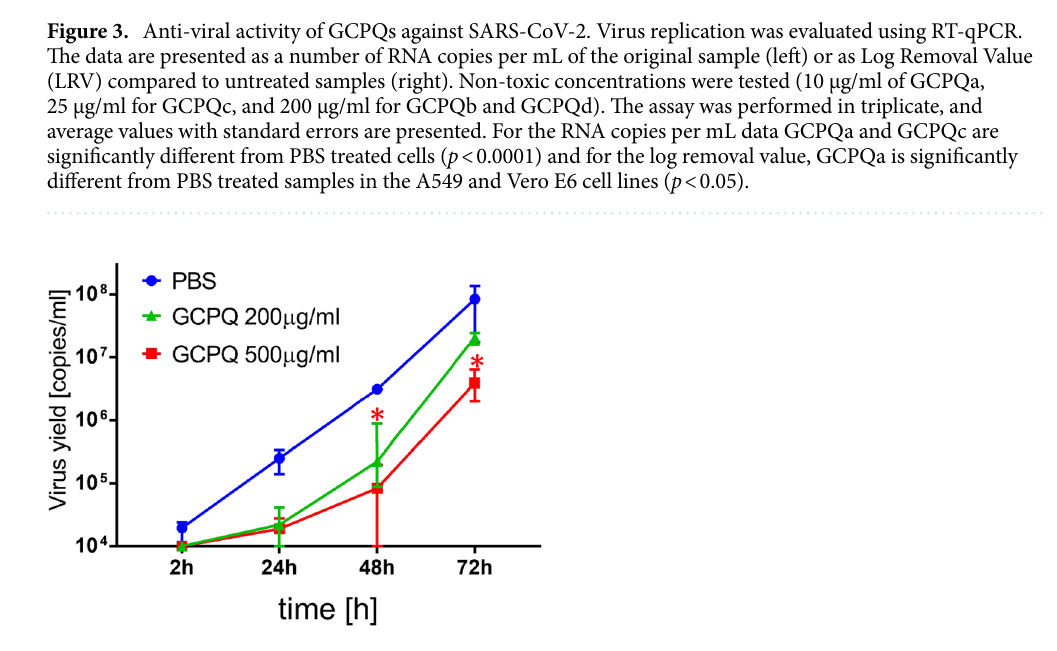
Figure 4. Replication of SARS-CoV-2 in fully differentiated tissue cultures of the human respiratory epithelium (HAE) in the presence or absence of GPCQ. Virus replication was evaluated using RT-qPCR. The data are presented as a number of viral copies per ml. The assay was performed in triplicate, and median values with range are presented. At the 48 and 72 h time points, GCPQa at 500 μg/ mL is significantly different from PBS treated samples ( p <